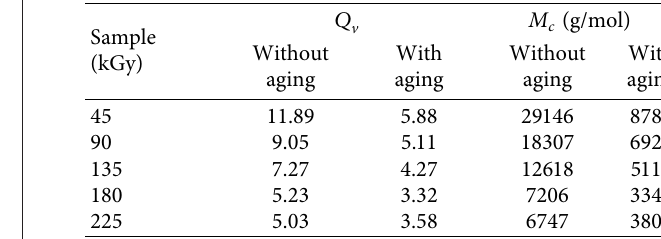
Table 2: Effects of radiation dose on the volume swelling and the molecular weight between crosslinks of BR/NR blends.